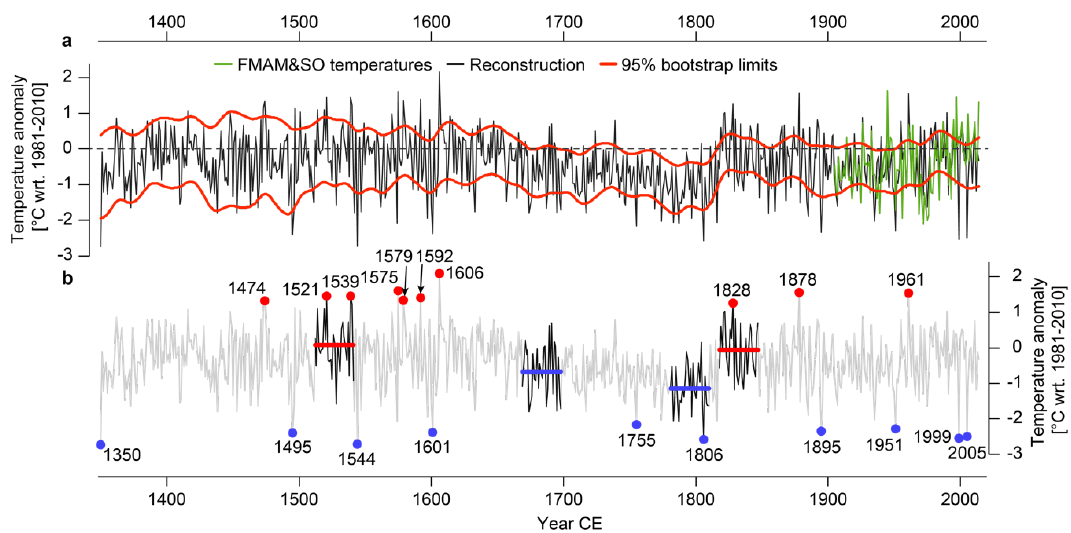
Figure 9. Cazorla temperature reconstruction and extremes back to 1350 Coefficient of Efficiency (CE). ( a ) The ABC300 MXD chronology (black) scaled over the 1905–2014 period against regional FMAM&SO temperatures (green) shown together with the 30-year smoothed 95% bootstrap confidence limits (red). ( b ) The same reconstruction with the 10 coldest and warmest years highlighted in blue and red, and the coldest and warmest 30-year periods before and after 1700 CE (blue and red horizontal lines).